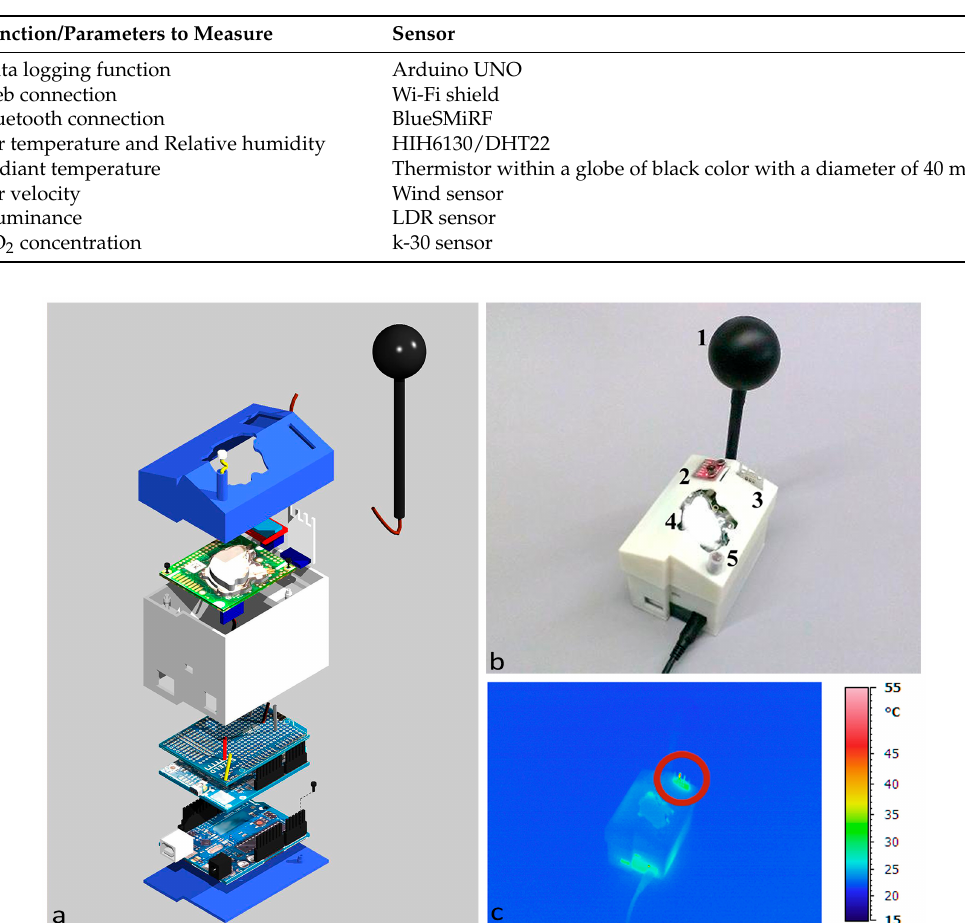
Figure 1. First case: ( a ) assembling scheme; ( b ) position of sensors; and ( c ) thermal imaging at starting time.